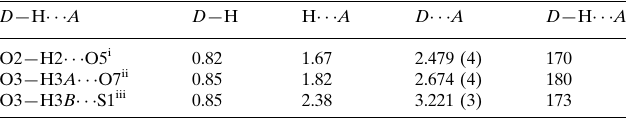
Hydrogen-bond geometry (A˚ , (cid:2)